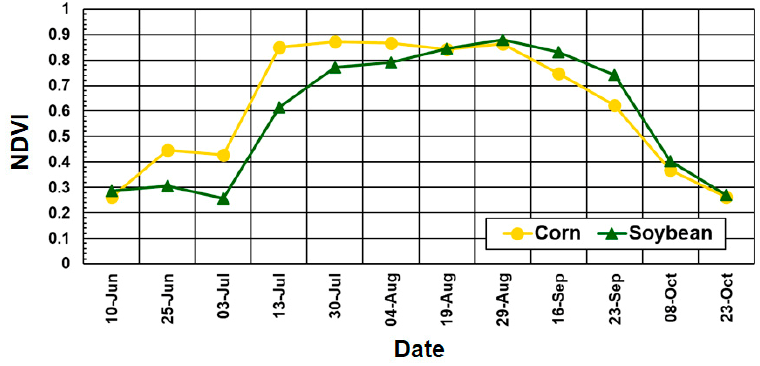
Figure 2. Temporal profiles of NDVI values for corn and soybean in 2019.